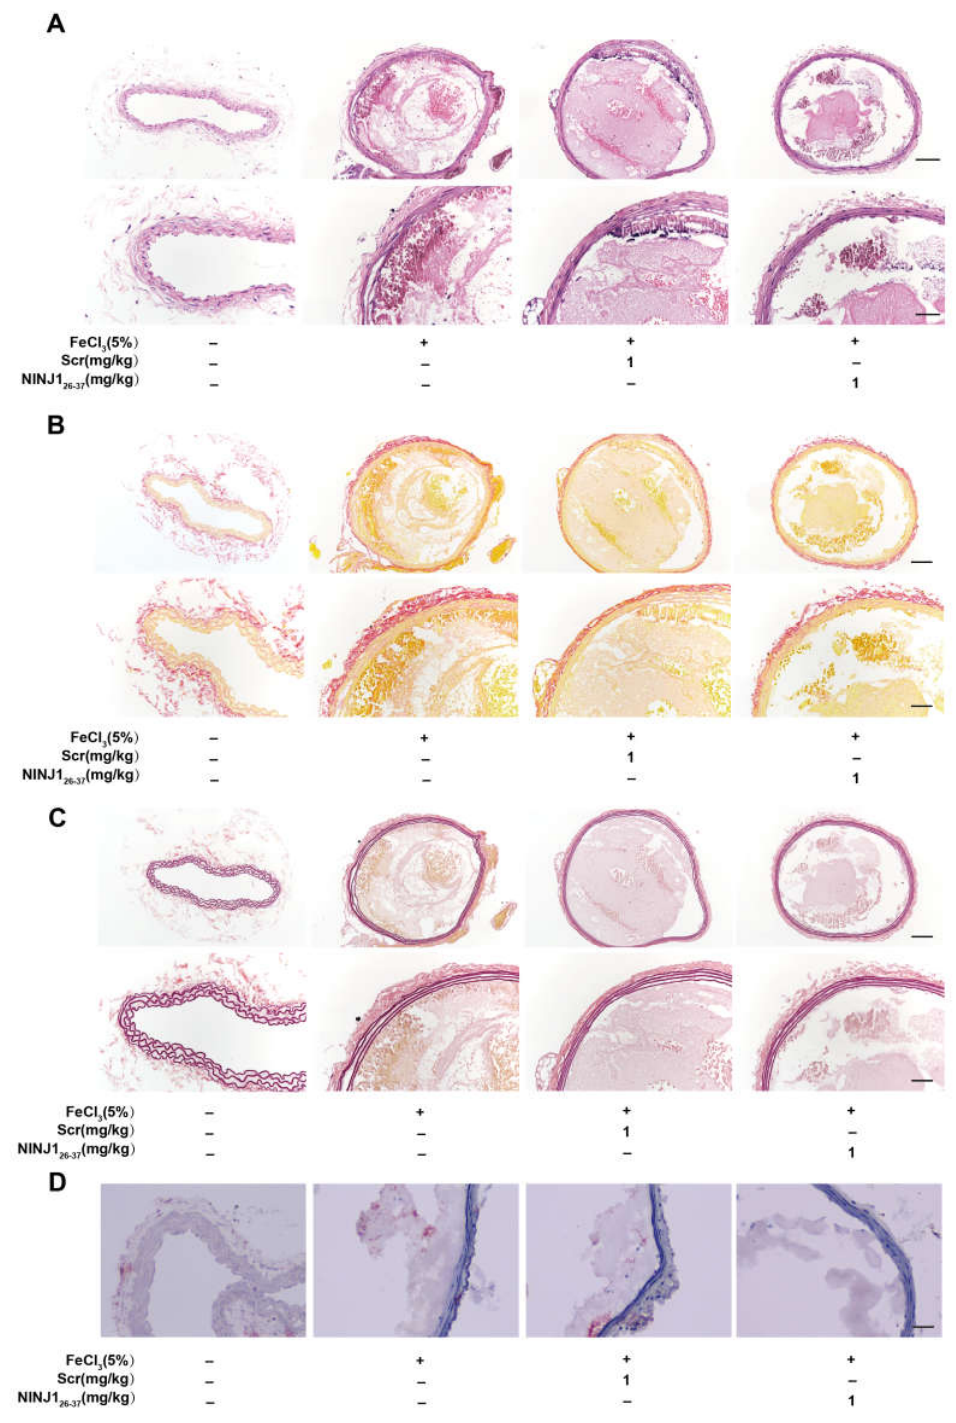
Figure 5. Inhibition of NINJ1 reduced thrombosis without affecting its stability. The panel shows images of carotid thrombosis (5% FeCl 3 injury) with representative ( A ) hematoxylin-eosin staining, ( B ) Sirian red, ( C ) EVG (scale bar represents 100 μm or 50 μm), and oil ( D ) red staining, scale bar represents 100 μm.